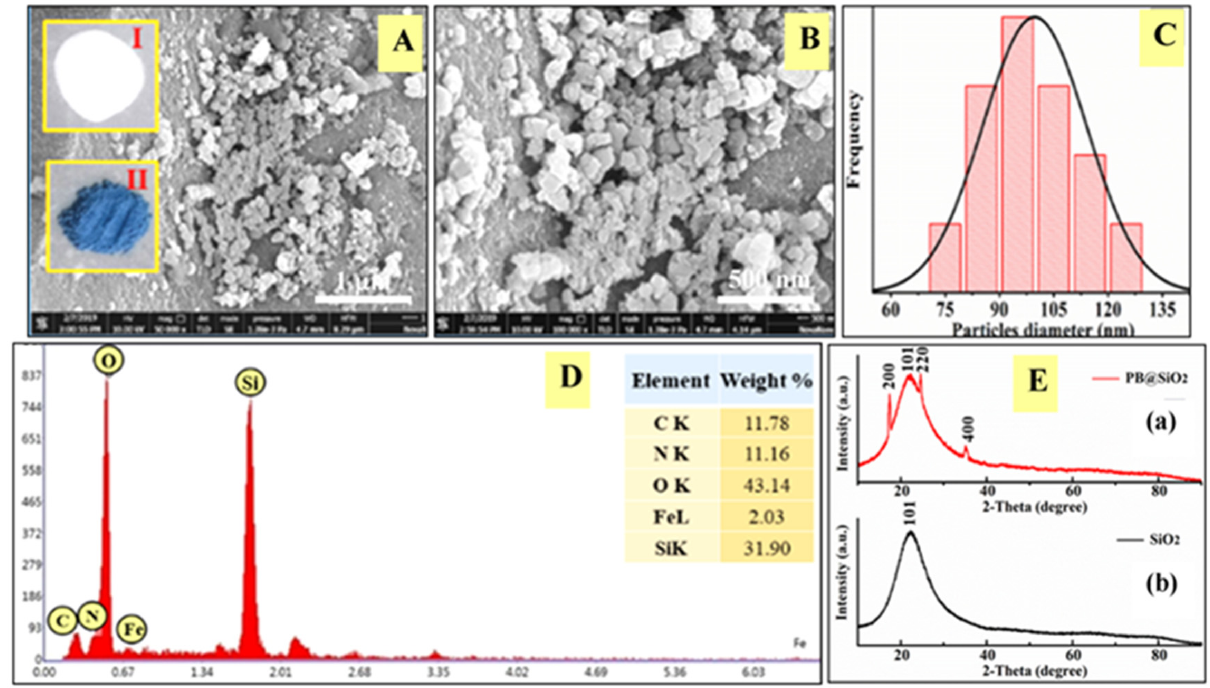
Figure 2. ( A , B ) HRSEM images of PBN@SiO 2 at two different magnifications. Inset of ( A ) shows photographic images of mesoporous silica (I) and PBN-inserted mesoporous silica (II). ( C ) The particle size distribution of PBN within mesoporous silica. ( D ) The EDX spectrum of PBN-inserted mesoporous silica. ( E ) XRD spectra of SiO 2 ( a ) and PBN@SiO 2 ( b ).